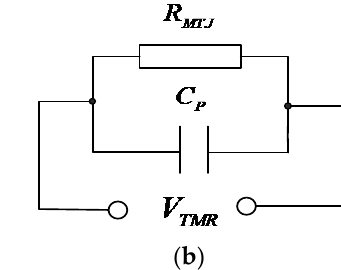
Figure 4. Structure of the TMR sensor. ( a ) Internal parasitic capacitance of the TMR sensor, ( b ) internal equivalent structure of the TMR sensor.